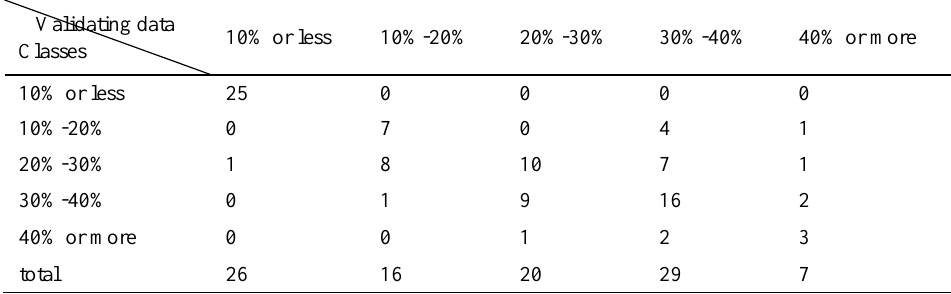
Table 2. The precision analysis in bare soil